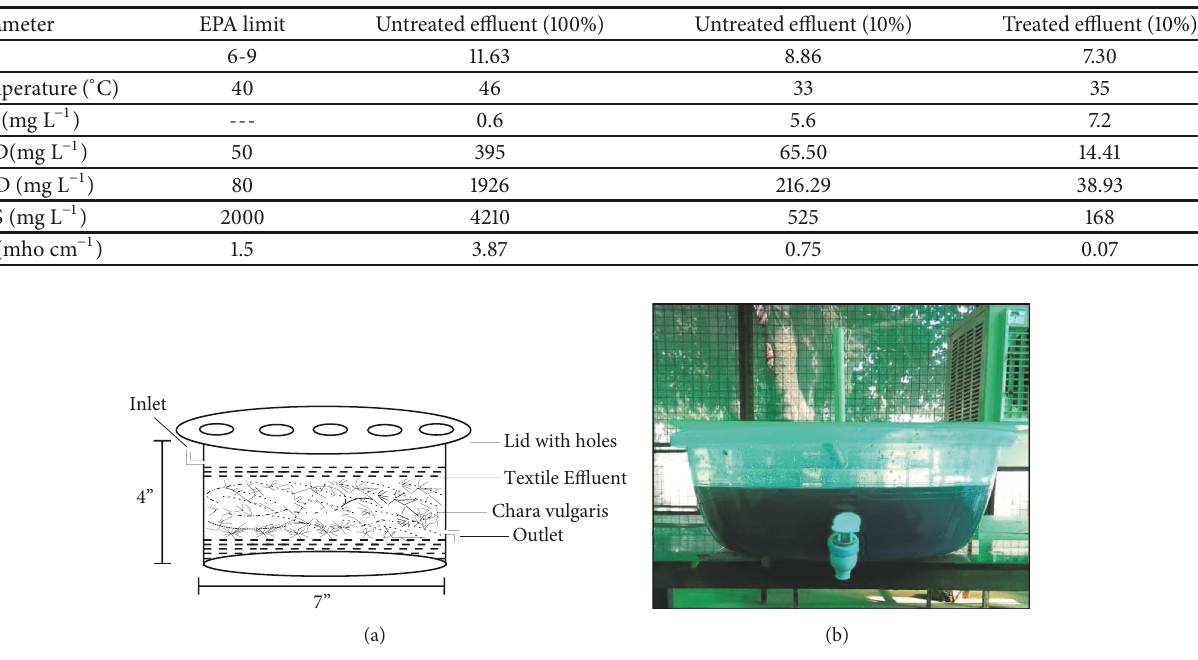
Table 1: Comparison of physiochemical parameters of untreated effluent (100%) and 10% treated effluent before and after treatment of 120 h with EPA discharge limit.